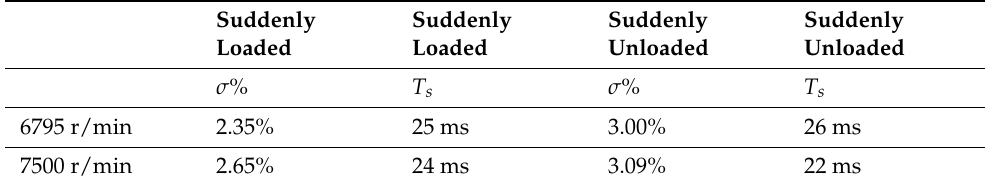
Table 7. Results of the dynamic performance